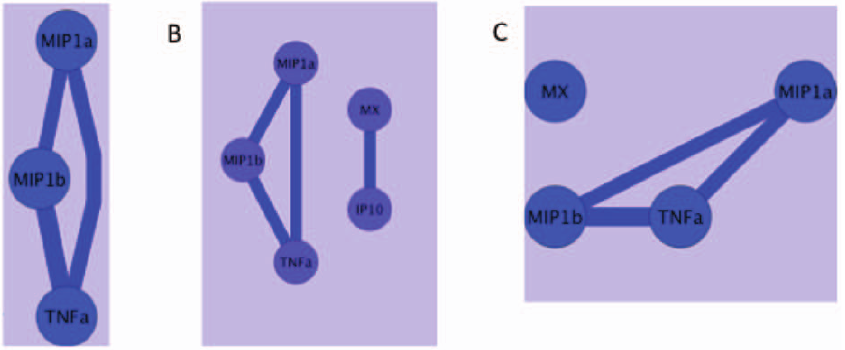
Figure 3. Network of statistical correlations between mRNA levels of immune mediators. After unbiased analysis of potential associations between the levels of every mRNA levels measured using a Spearman’s correlation function there was a limited network of strong ( . 0.7) correlations between mRNA levels of A) 3 cytokine/chemokines at Time point 1; B) 3 cytokines/chemokines; and 2 Interferon-stimulated genes at Time point 2. C) networks of strong correlations that existed at both Time 1 and Time 2. Blue circles indicate host gene mRNA levels. The lines indicate a positive correlation between the parameters in the circles and the width of the line is proportional to the strength of the correlation.